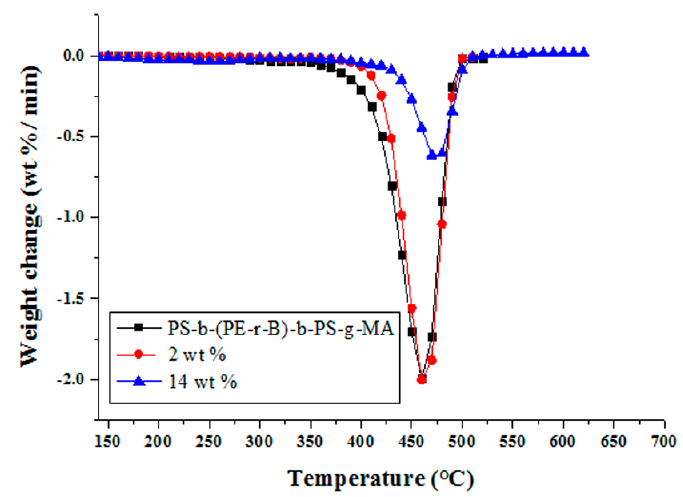
Figure 12. Derivative thermogravimetry (DTG) of neat PS- b -(PE- r -B)- b -PS- g -MA and composites with 2 wt % and 14 wt % Cu–Al 2 O 3 loading.